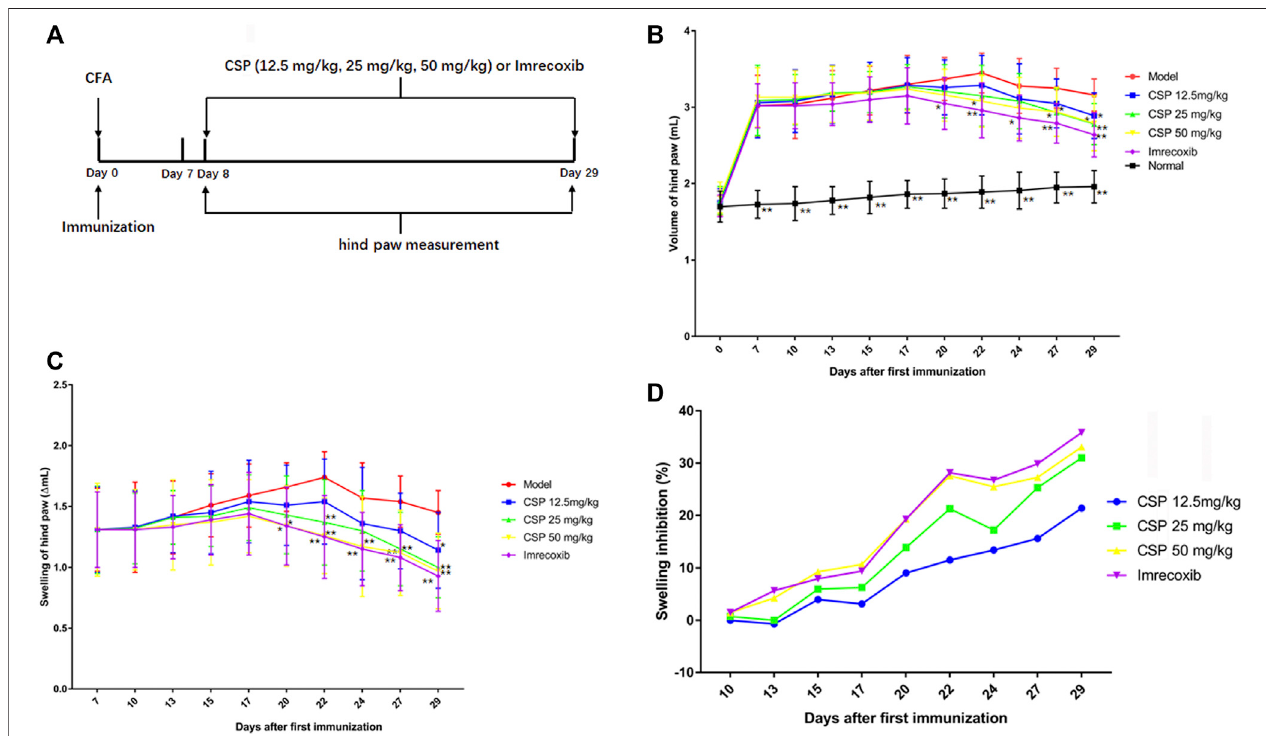
FIGURE3| CSPsuppressedpawswellinginCFAinducedarthritis.Theschematicexperimentalschedule (A) ,pawswelling (B,C) ,andswellinginhibition (D) .CSP were administered for 3 weeks from the day 8 after the injection of CFA. * p < 0.05, ** p < 0.01 compared with model group.